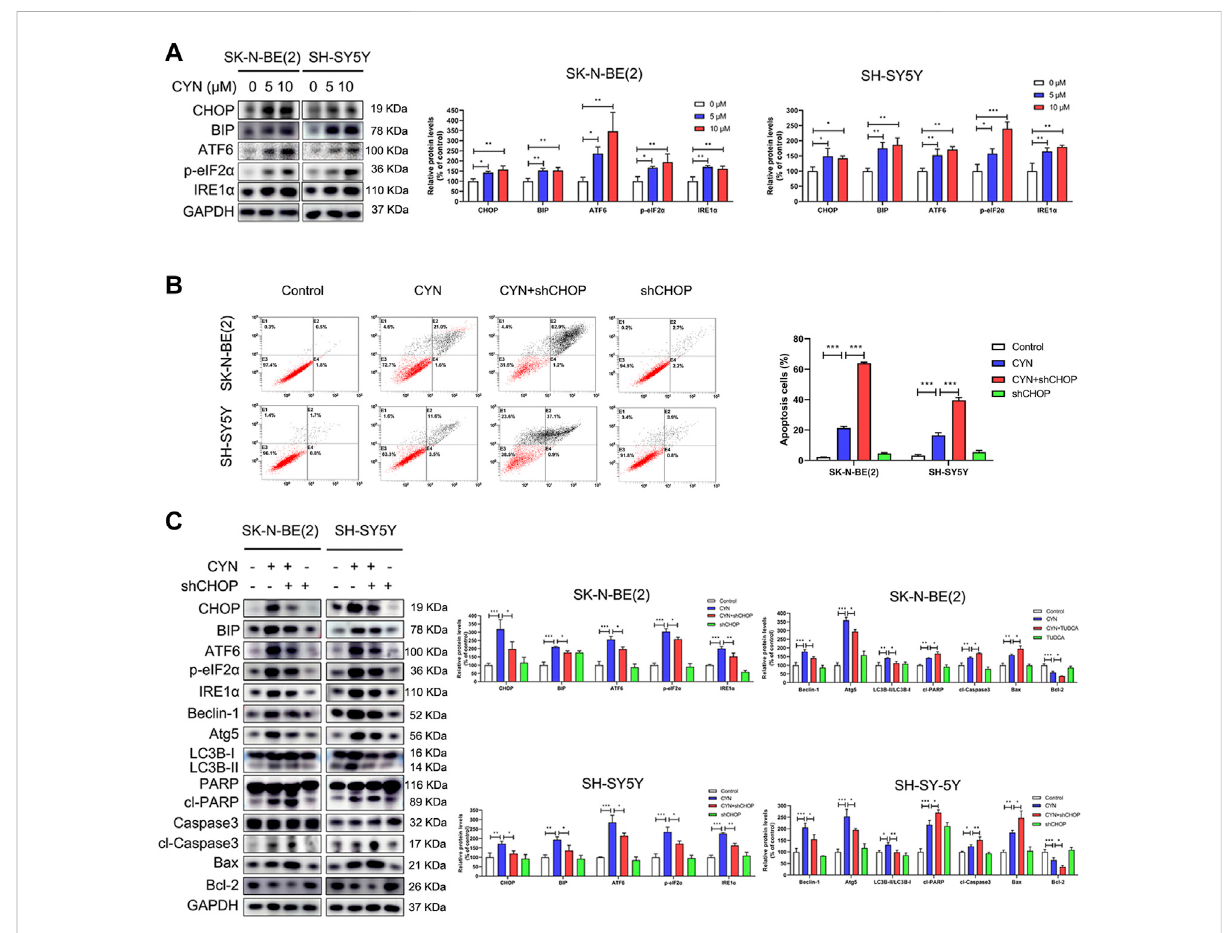
FIGURE 5 Relationship between ER stress, apoptosis and autophagy in NB cells treated by CYN. (A) Levels of ER stress-related proteins were analyzed by western blot. (B) Cell apoptotic ratio was measured and analyzed by fl ow cytometry. (C) Western blotting analysis detected the expression of ER stress-, autophagy- and apoptosis-related proteins. * p < 0.05, ** p < 0.01, *** p < 0.001 versus the control group. * p < 0.05, ** p < 0.01, *** p < 0.001 versus the CYN